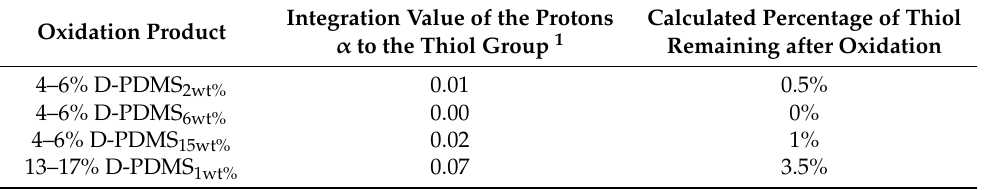
Table 2. Proton integrations of the -C H 2 SH peaks of liquid D-PDMSs and estimates of percentages of residual thiol.